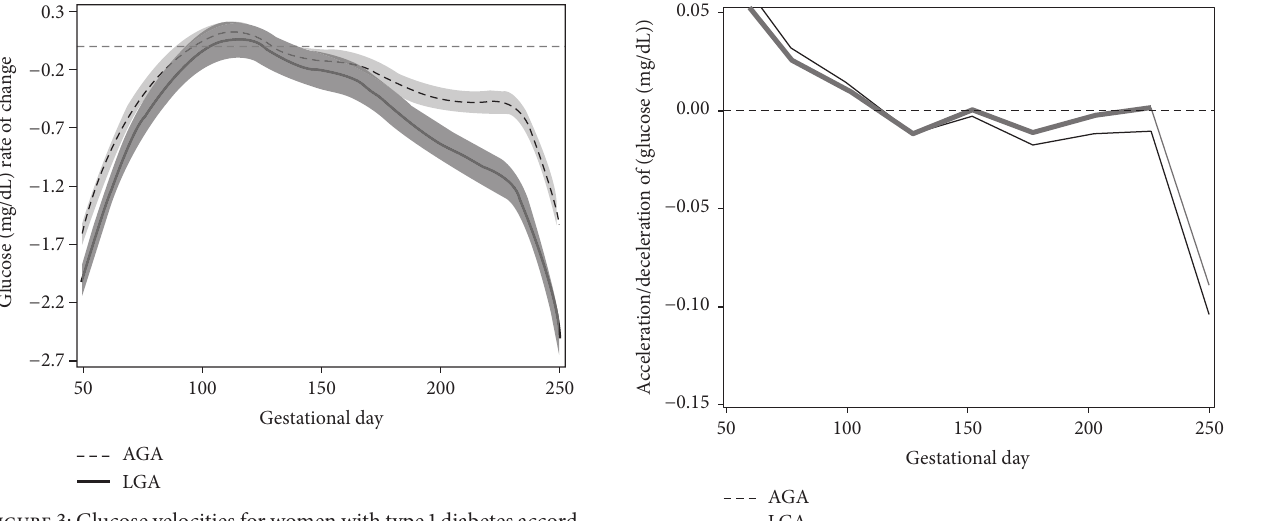
Figure 3: Glucose velocities for women with type 1 diabetes accord- ing to LGA (solid line) and AGA (dashed line) birth outcomes. Rates of change in glucose for each group were calculated based on the first derivative ( 𝑦 -axis, mg/dL/day) against gestation time ( 𝑥 -axis, in days). The overlapping region in 95% pointwise confidence interval indicates the gestational time period in which both LGA and AGA have similar rates of change in glucose readings. It is illustrated here that women delivering LGA infants have more rapid decline in glucose velocity.